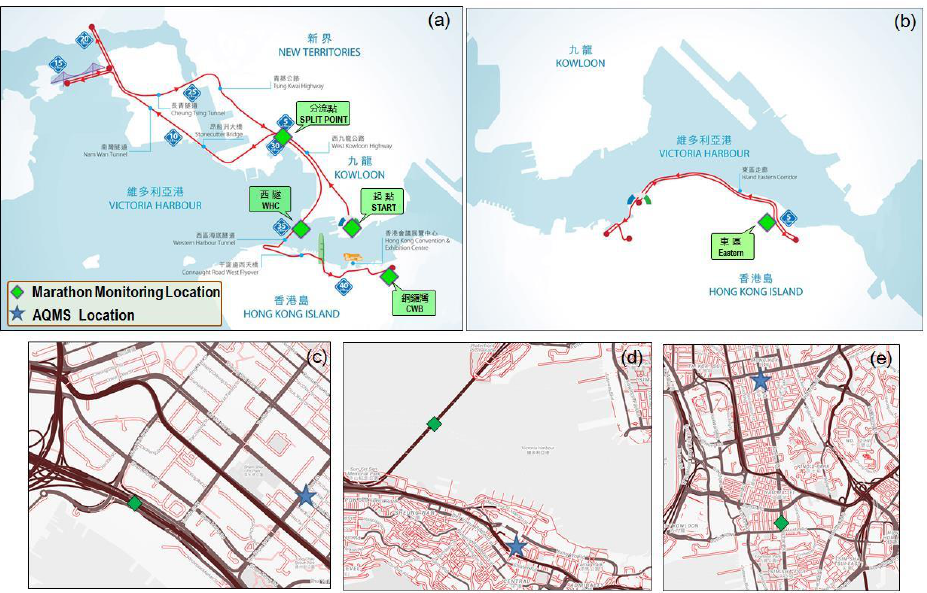
Figure 3. Air monitoring stations along: ( a ) the full/half marathon route; ( b ) the 10-km marathon route; the nearby AQMS run by HKEPD ( c ); Sham Shui Po AQMS near SSP; ( d ) Central AQMS near West Harbor Crossing (WHC); ( e ) Mong Kok AQMS near Tsim Sha Tsui